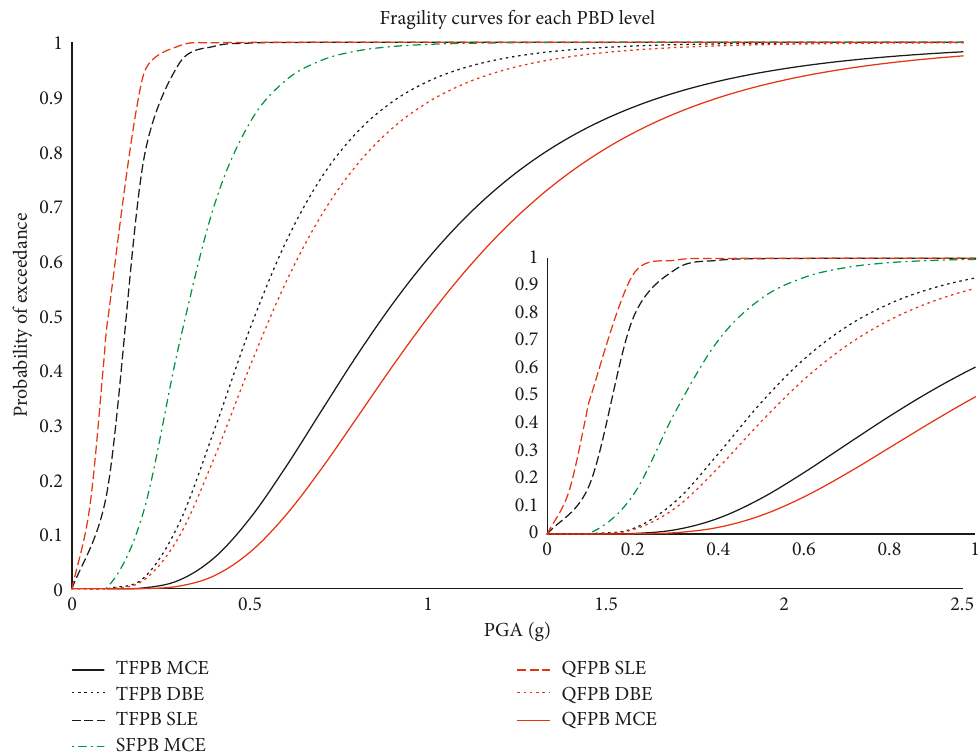
Figure 8: PBD fragility curves for SFPB, TFPB, and QFPB isolation